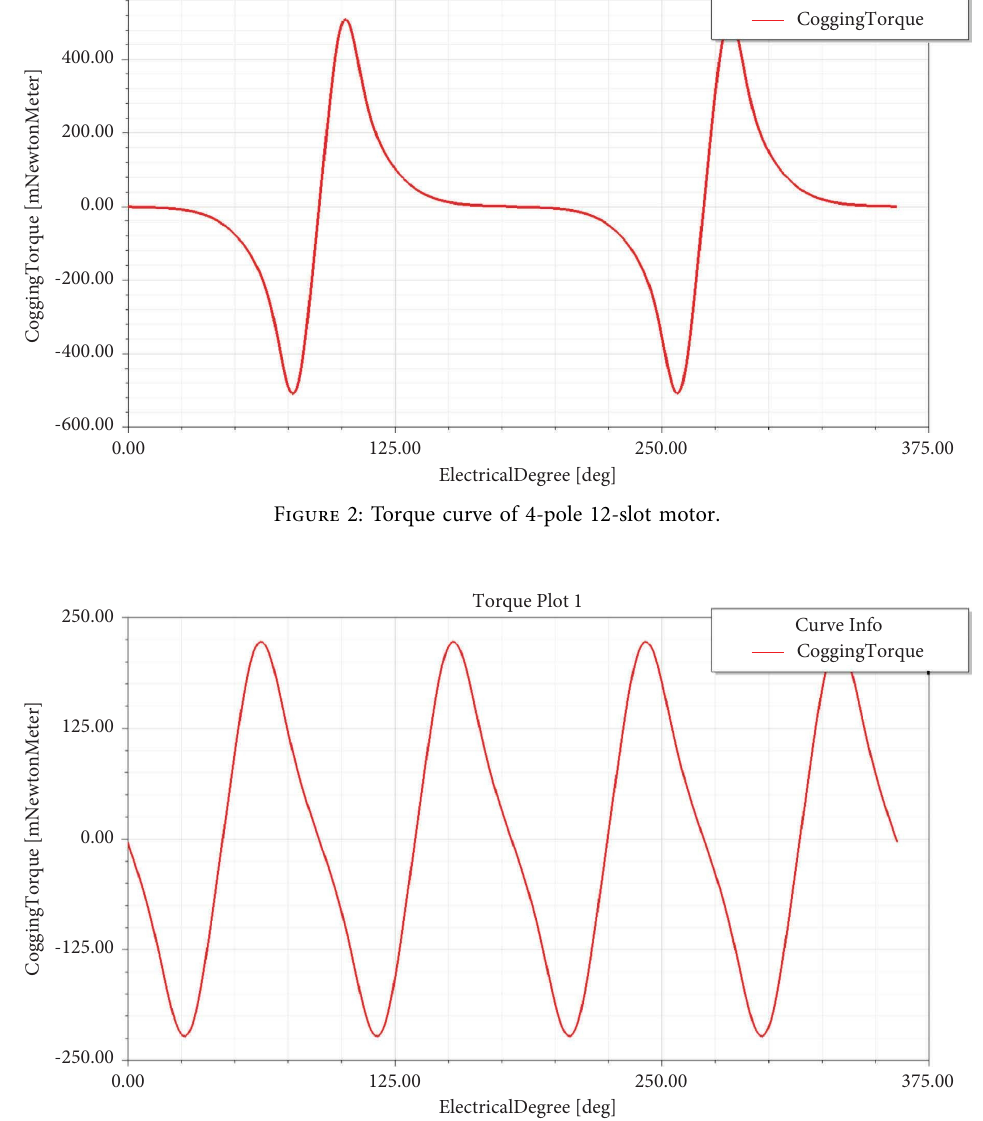
Figure 3: Torque curve of 4-pole 18-slot